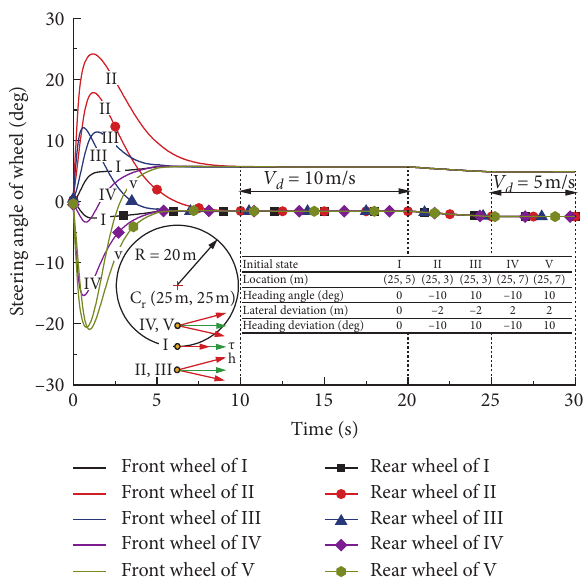
Figure 14: Time histories for steering angles of the vehicle that follows the circular path from different initial